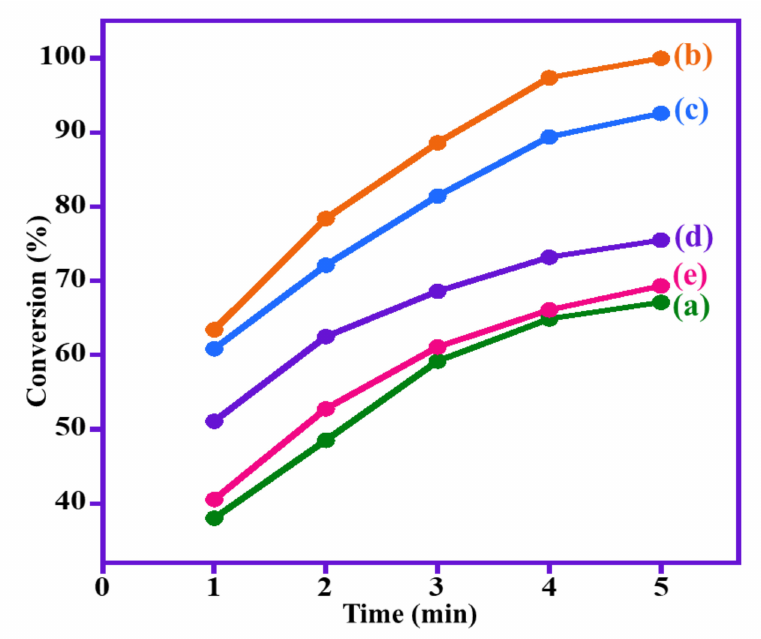
Figure 8. Graphical illustration of BOH dehydrogenation using ( a ) (1%) ZnO–MnCO 3 , ( b ) (1%) ZnO–MnCO 3 /(1%-NDG), ( c ) (1%) ZnO–MnCO 3 /(3%-NDG), ( d ) (1%) ZnO–MnCO 3 /(5%-NDG), and